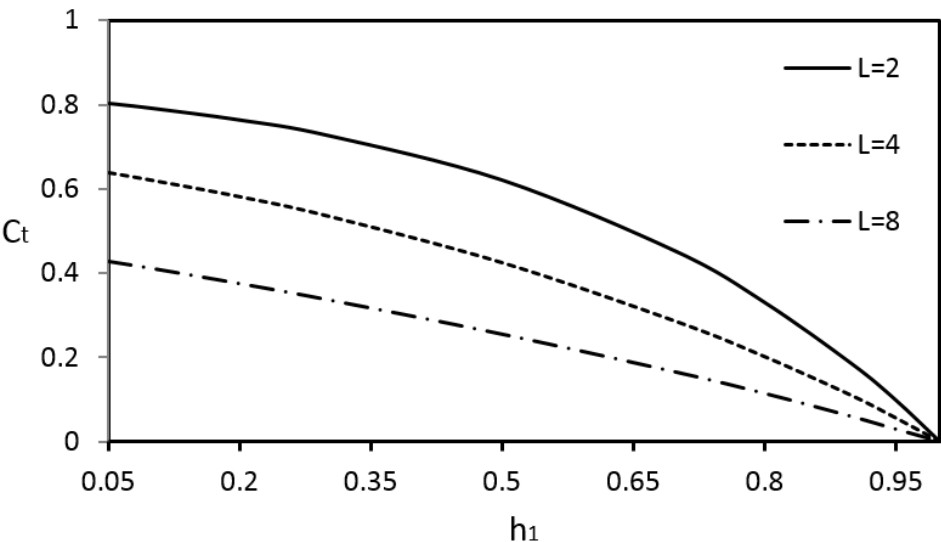
Figure 8. Variations of transmission coefficient (C t ) versus body draft ( h 1 ) for the cases of L = 2, 4, and 8 using the incident wave conditions of α = 0.3, λ = 15.